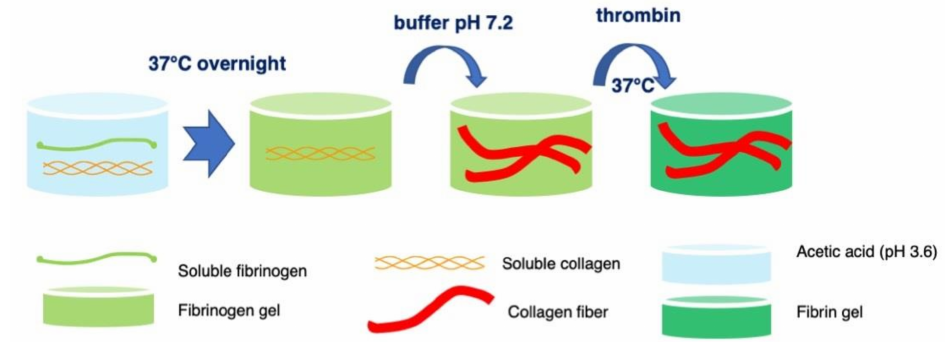
Scheme 1. Overview of the synthetic pathway to fibrin-collagen